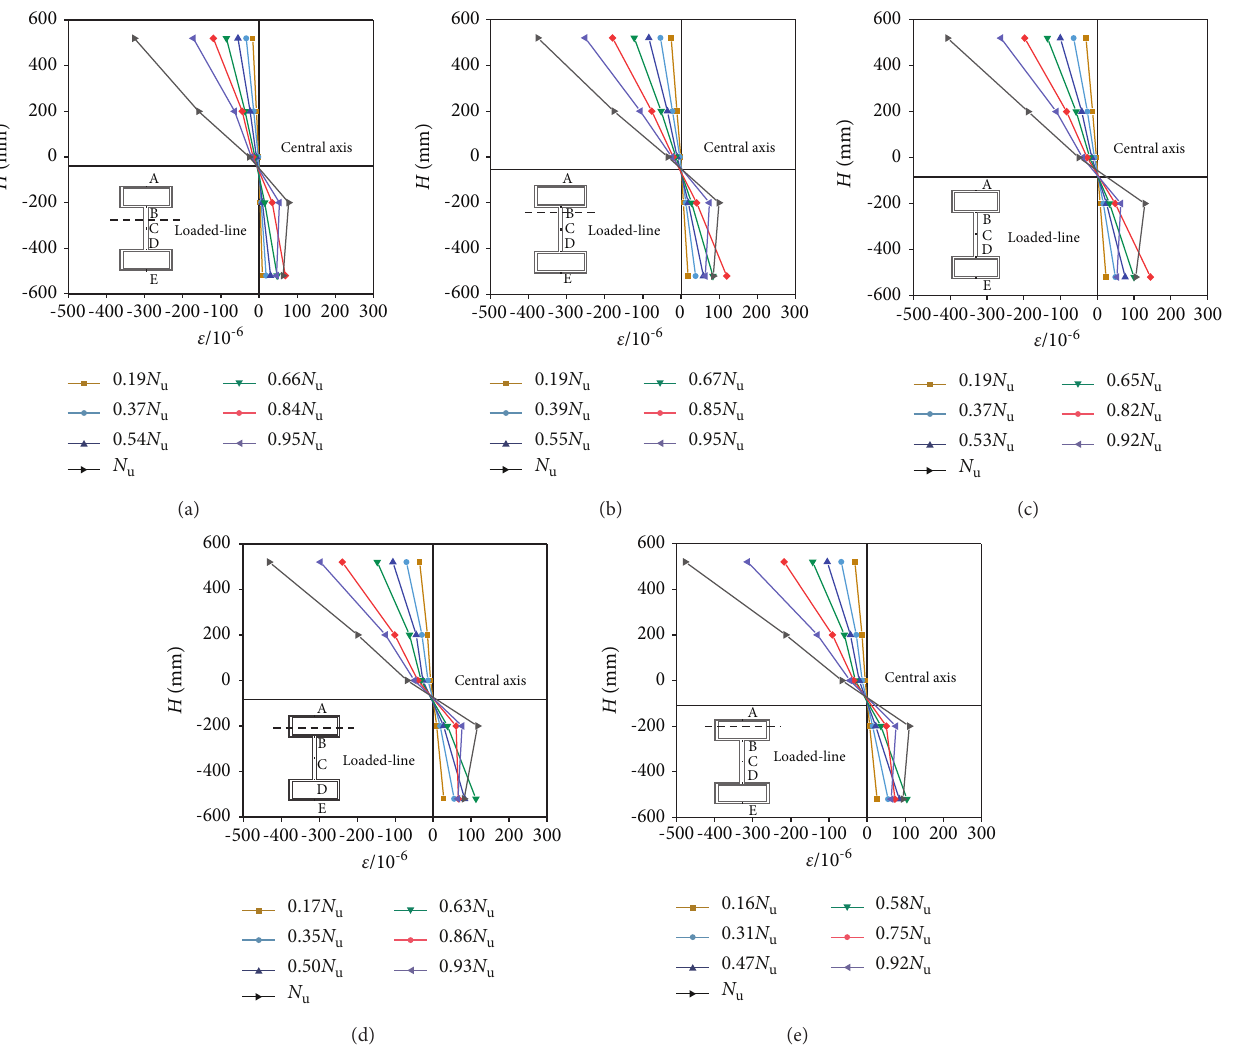
Figure 13: Longitudinal strain distribution of mid-span section of specimens with different eccentricity. (a) STHCC-1. (b) STHCC-2. (c) STHCC-3. (d) STHCC-4. (e) STHCC-5.